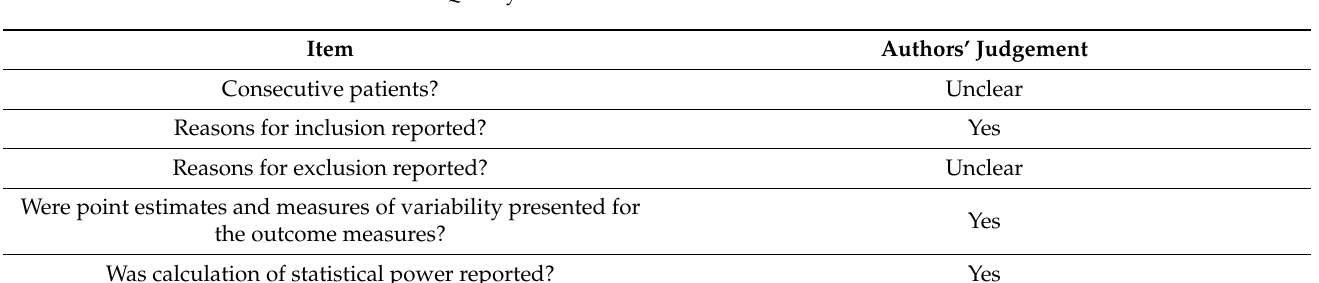
Table A14. Quality